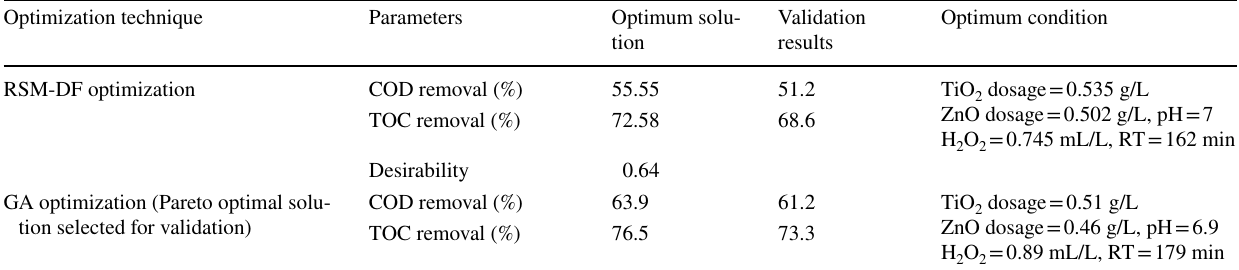
Table 6 Optimum RSM and GA solutions for COD and TOC removal (%) efficiencies and experimental validation results Optimization